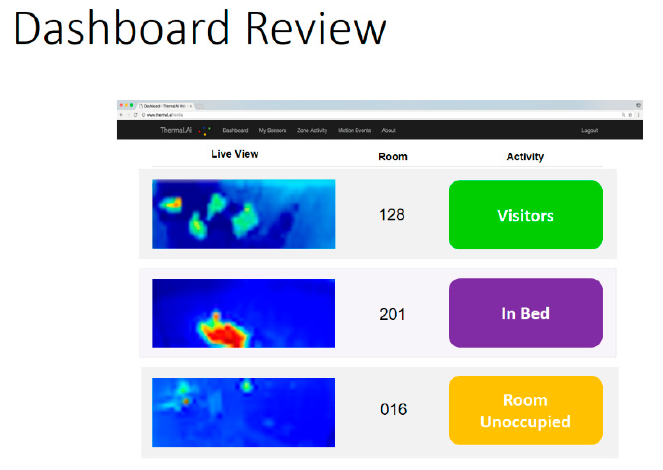
Figure 9. Dashboard review.